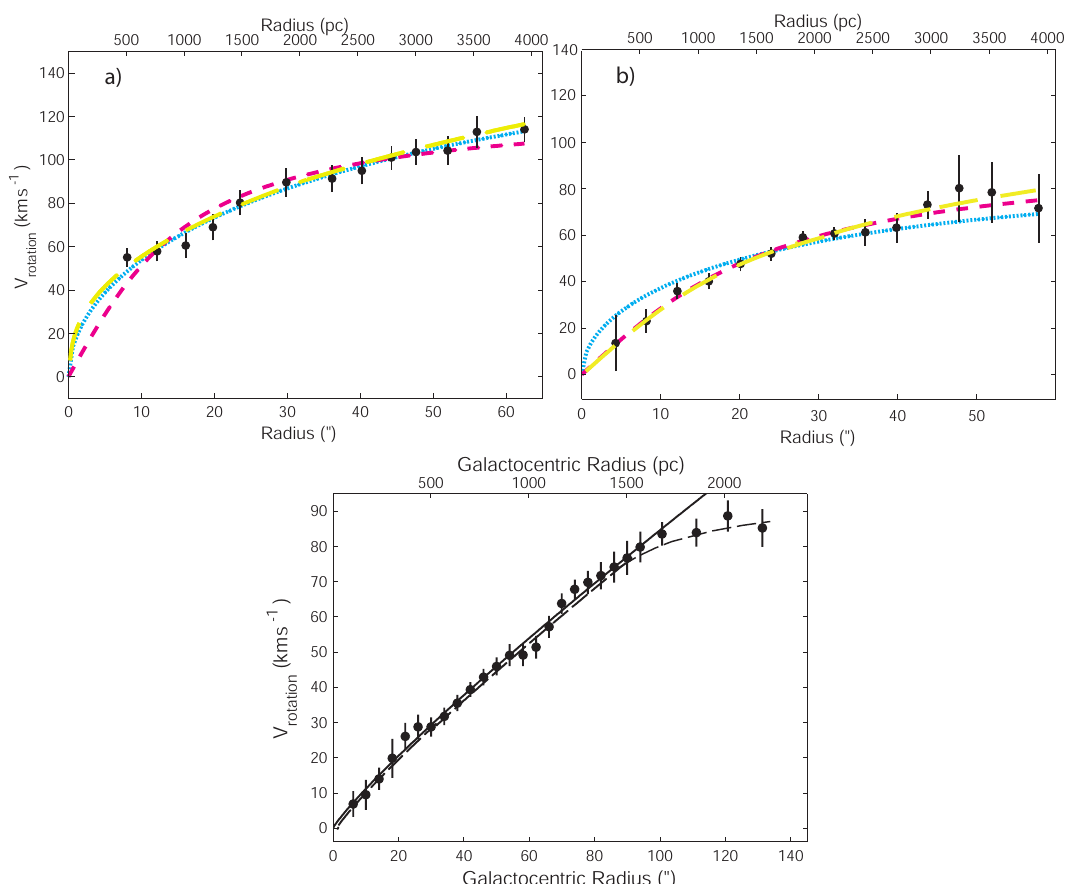
Figure 4. Top left panel: DM halo RC of NGC5963 (black points with error-bars) computed by [190]. The dotted cyan represents the RC obtained from a fitted NFW profile, the short-dashed magenta, from the pseudo-isothermal profile fit (ISO), and the yellow dashed line, from the model of [168]. Top right panel: same as the top left panel, for NGC5949. Bottom panel: DM halo RC of NGC2976 (black points with error-bars) obtained by [190]. The solid line is the RC computed from a power-law fit to the corresponding density (slope (cid:39) 0.01), and the dashed line, the RC obtained by the model of [168] (from whom this figure is